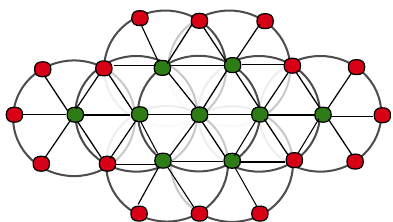
Figure 5. dSPAC topology example. Green circles are sink nodes and red circles are leaf